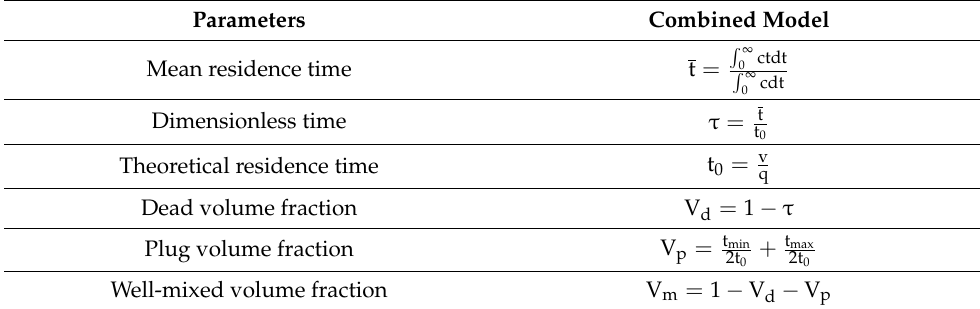
Table 2. Analysis approach for the residence time distribution (RTD) curve [38–40].